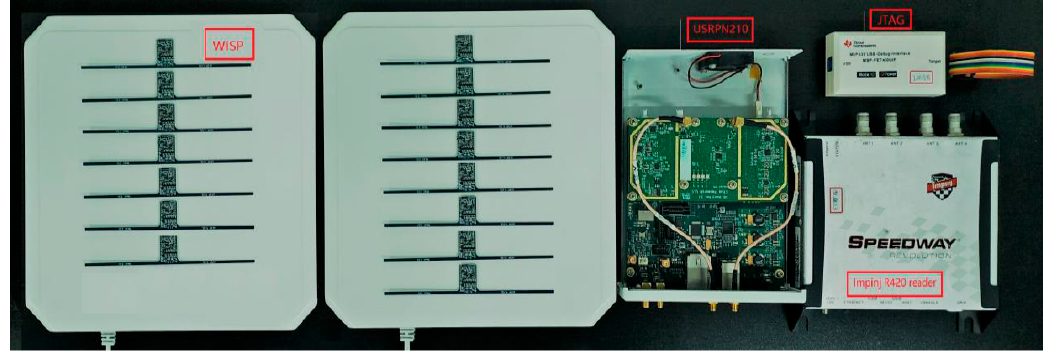
Figure 7. Laboratory equipment.